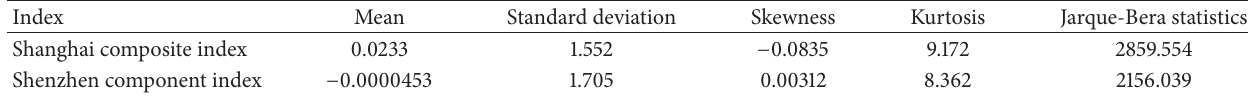
Table 2: Descriptive statistics for Shanghai composite index and Shenzhen component